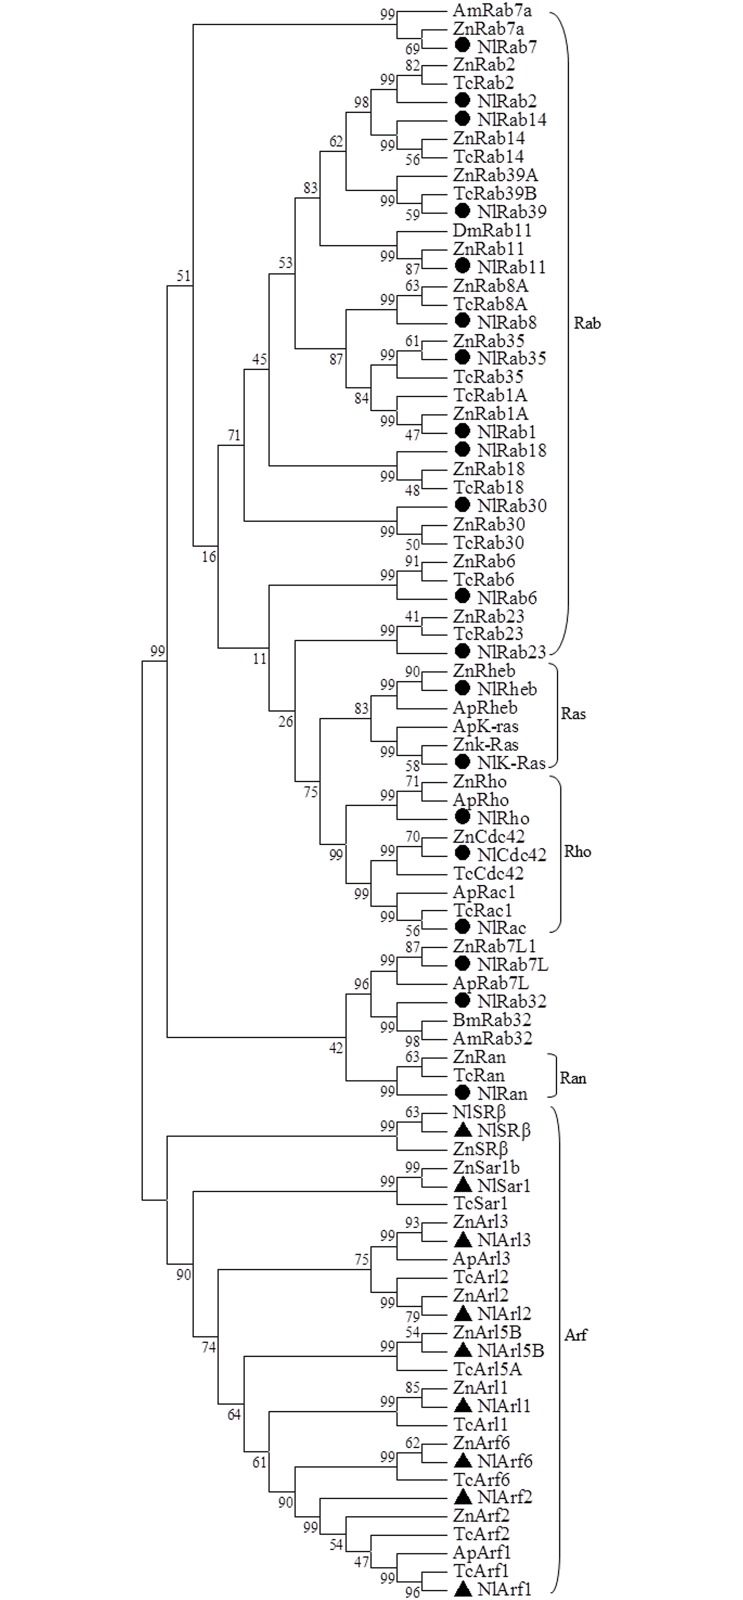
Unrooted phylogenetic tree of RSGs from N.lugens and representative insect species.An unrooted phylogenetic tree was constructed by the neighbour-joining method, together with 1000 bootstrap replicates based on the protein sequence alignments. N.lugens proteins in Class I were marked black circle. N.lugens in Class II was marked with black triangle. Gross Ras subfamily groupings were shown on the right. (See S2 Table for details of GeneDB accession numbers).